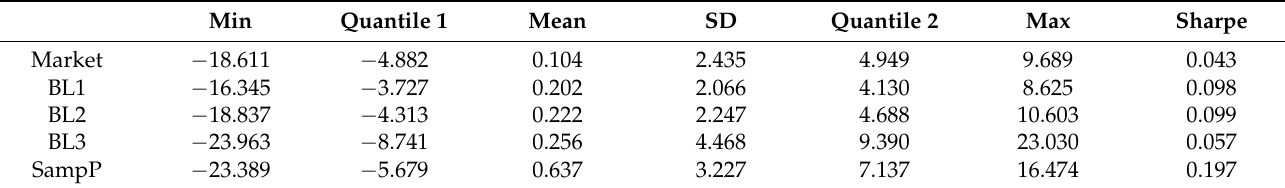
Table 2. Statistical summary of the simulated portfolio’s returns.